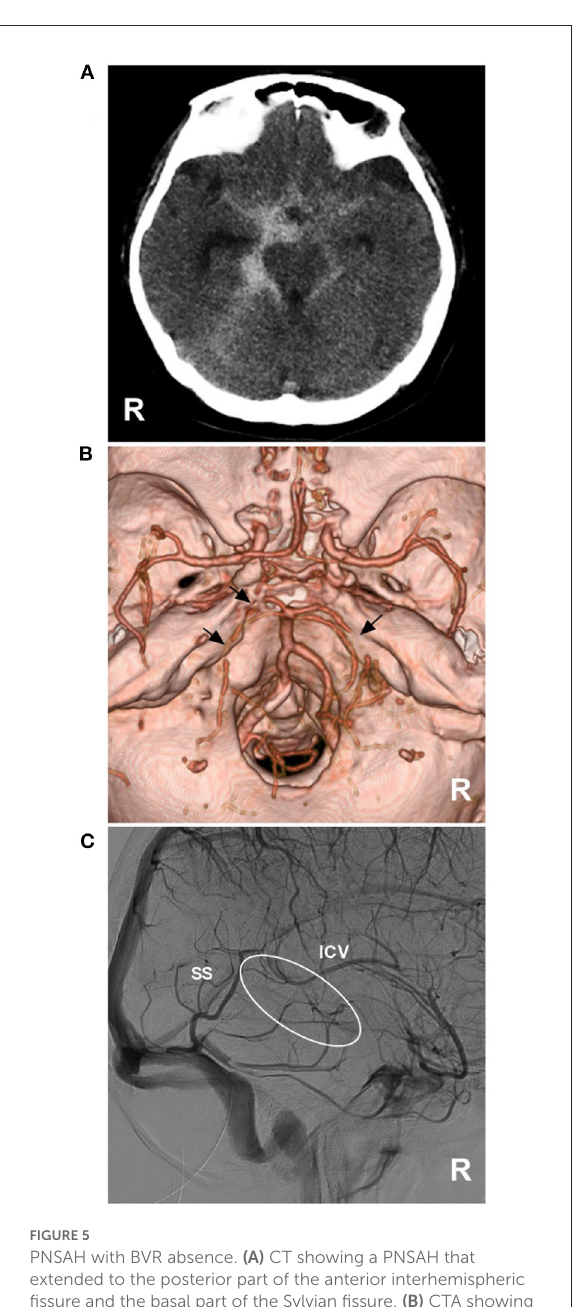
FIGURE5 PNSAH with BVR absence. (A) CT showing a PNSAH that extended to the posterior part of the anterior interhemispheric fissure and the basal part of the Sylvian fissure. (B) CTA showing the multiple vasospasms (arrows) of the bilateral posterior cerebral arteries, without positive findings of bleeding. (C) DSA showing the absence of the right BVR (circle). BVR, Basal vein of Rosenthal; CT, computed tomography; CTA, computed tomography angiography; DSA, digital subtraction angiography; ICV, internal cerebral vein; PNSAH, perimesencephalic non-aneurysmal subarachnoid hemorrhage; R, right; SS, straight sinus.